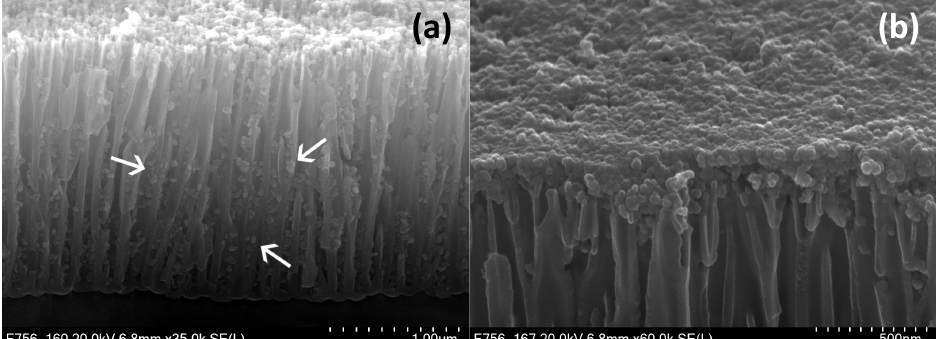
Figure 6. Fractured cross-sections of anodized layers impregnated with Tronox PC-S7 ( a ) and Evonik W2730X ( b ). Titania particles are marked exemplarily by arrows.